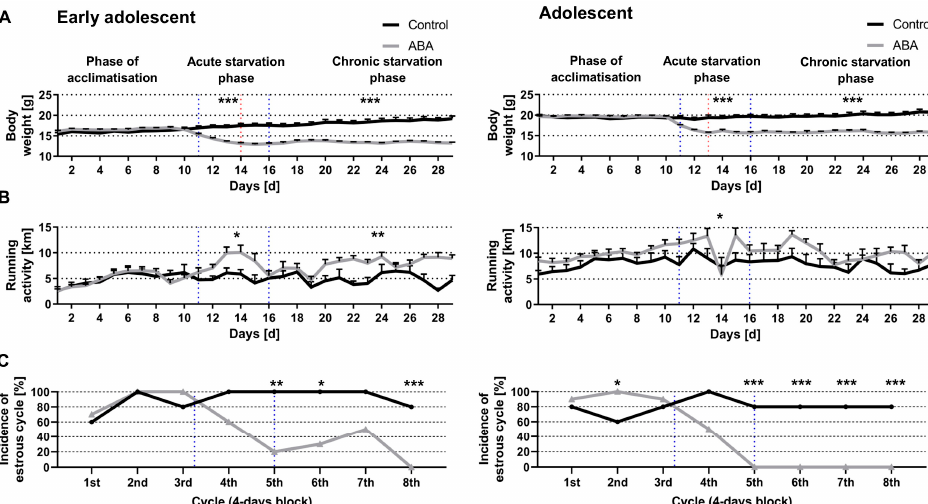
Figure 4. Chronic starvation in ABA mice leads to hyperactivity and amenorrhea. ( A ) The body weight, ( B ) running wheel activity explored with sensors and ( C ) incidence of the estrous cycle during chronic starvation in early adolescent (left) and adolescent mice (right). The blue dotted lines show the beginning of acute and chronic starvation phases, whereas the achievement of 20% body weight loss in ABA groups is presented with red dotted lines. ( A , B ) * p ≤ 0.05, ** p ≤ 0.01, *** p ≤ 0.001, two-way ANOVA with repeated measurements. (C) Chi-squared tests investigating the incidence of estrous cycle in control and ABA mice.